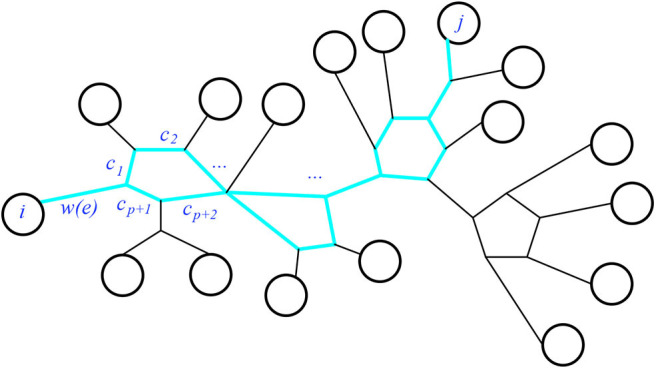
The highlighted subgraph is the pairwise circuit Pij.